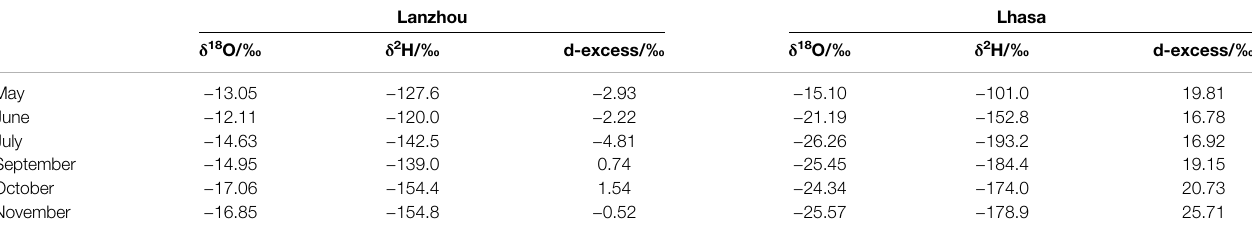
TABLE 2 | Comparison of the monthly average atmospheric water vapor isotope values of Lanzhou and Lhasa.